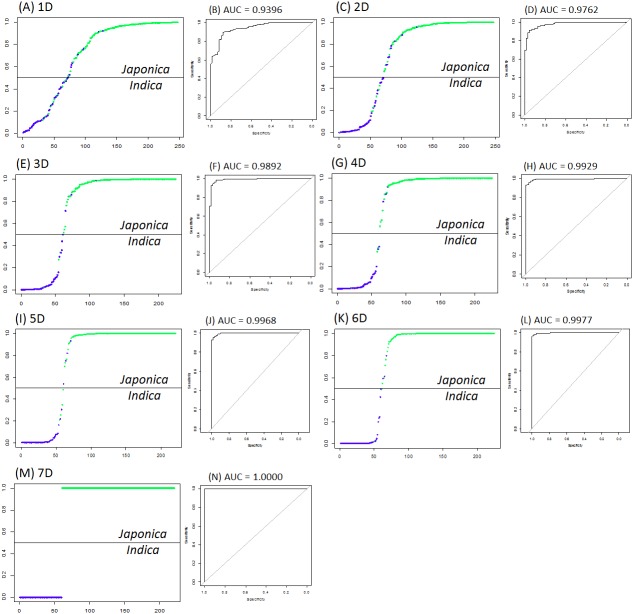
The best indica/japonica classification for each set (1D to 7D).(A) The best indica/japonica classification in 1D set, (B) the ROC curve for Fig. 1A, (C) the best indica/japonica classification in 2D set, (D) the ROC curve for Fig. 1C, (E) the best indica/japonica classification in 3D set, (F) the ROC curve for Fig. 1E, (G) the best indica/japonica classification in 4D set, (H) the ROC curve for Fig. 1G, (I) the best indica/japonica classification in 5D set, (J) the ROC curve for Fig. 1I, (K) the best indica/japonica classification in 6D set, (L) the ROC curve for Fig. 1K, (M) the best indica/japonica classification in 7D set, (N) the ROC curve for Fig. 1M.